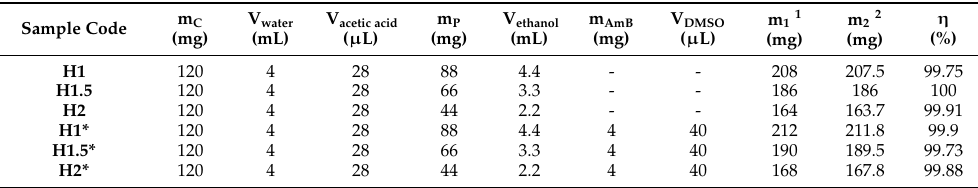
Table 1. The composition of the reference hydrogels and